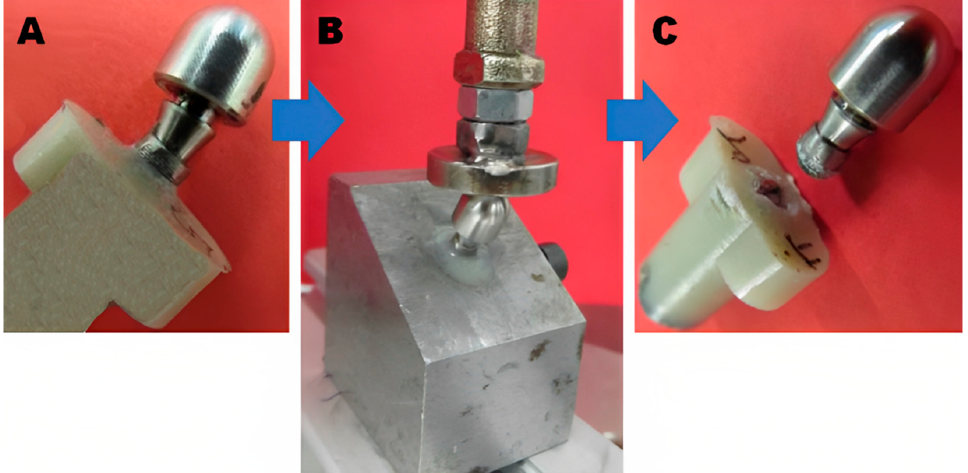
Figure 10. ( A ) Initial status with the dental implant in place and connected with the actuator, ( B ) the system mounted in the testing machine, and ( C ) the system after the test with its failure. We show below the charge cycle diagram. Our dental implants (screw plus barrette deployed) had an elastic force limit of 463.94 ± 75.03 SD N and a failure force of 663.21 ± 54.23 N. which failure does not occur for infinite loading cycles of trial limit) was 132.6 ± 10.4 N.